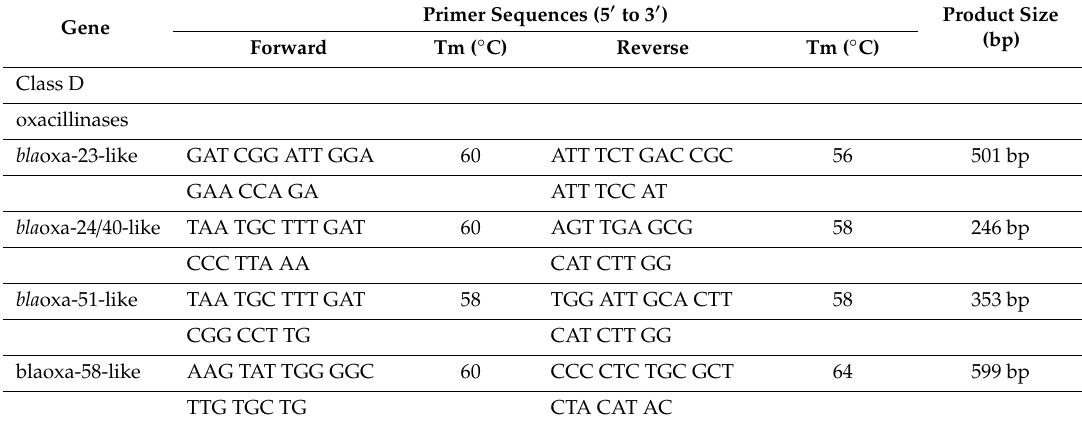
Table 3. Specific primers used for PCR amplification of OXA carbapenemase genes. Primer Sequences (5 (cid:48) to 3 (cid:48) Gene